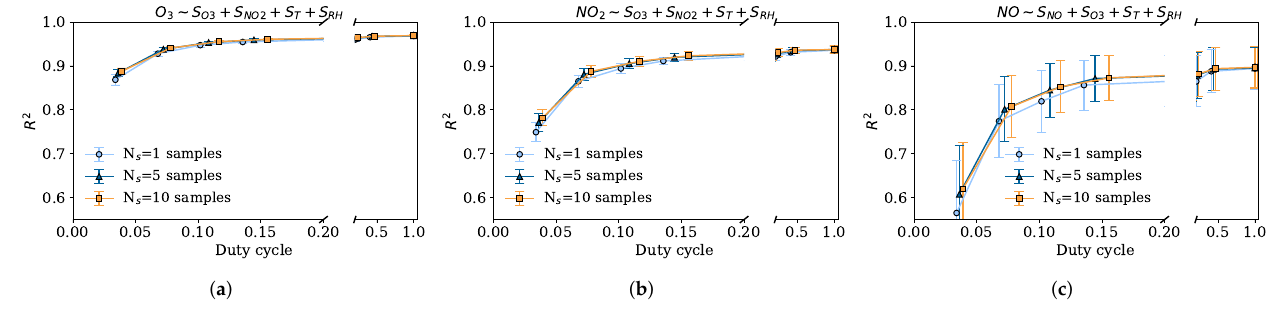
Figure 7. Average CV R 2 and 95% confidence intervals for different duty cycles with a sensor response time equal to 2 min (T r = 2min) using MLR. ( a ) Captor 20001 O 3 CV R 2 for different duty